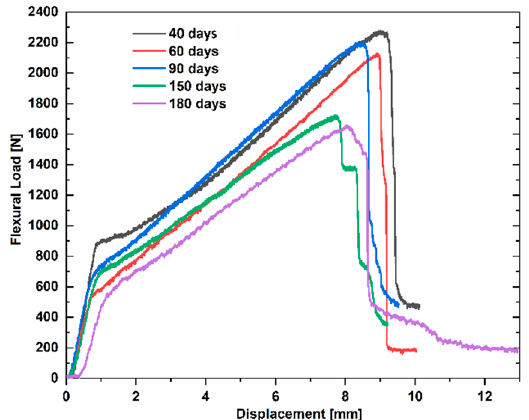
Figure 9. Flexural load-displacement curves of the specimens reinforced with four-layer basalt textile at the different periods of time.